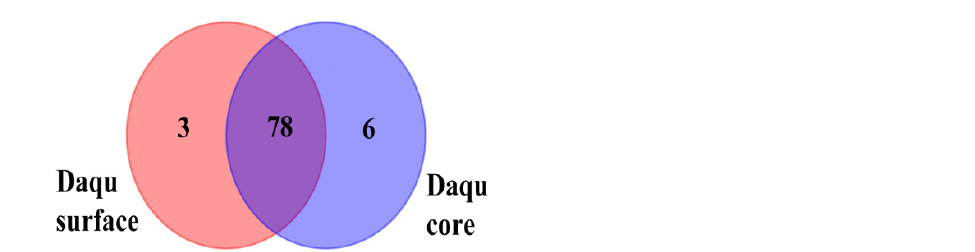
Figure 8. Veen diagram of the fungal community on Daqu surface and Daqu core during fermenta- tion.